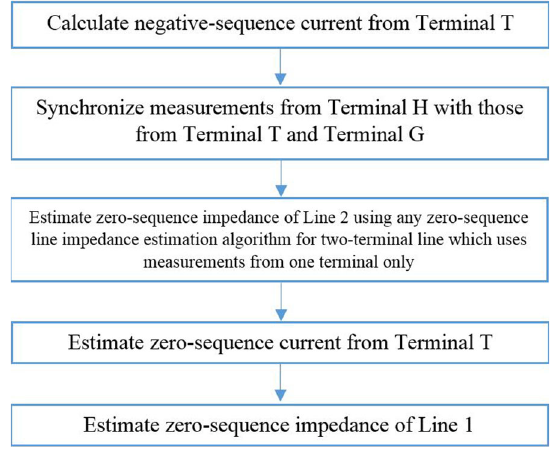
Fig. 5 Flow diagram depicting Approach 2 for calculating zero-sequence line impedance of all the sections of a three-terminal line using data from only two terminals